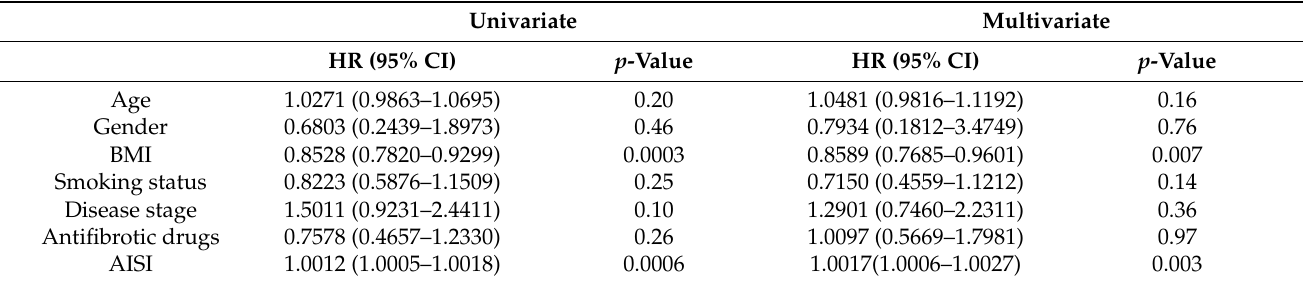
Figure 1. Survival of patients with idiopathic pulmonary fibrosis stratified by AISI at baseline. Table 5. Univariate and multivariate Cox regression models showing hazard ratios for the studied